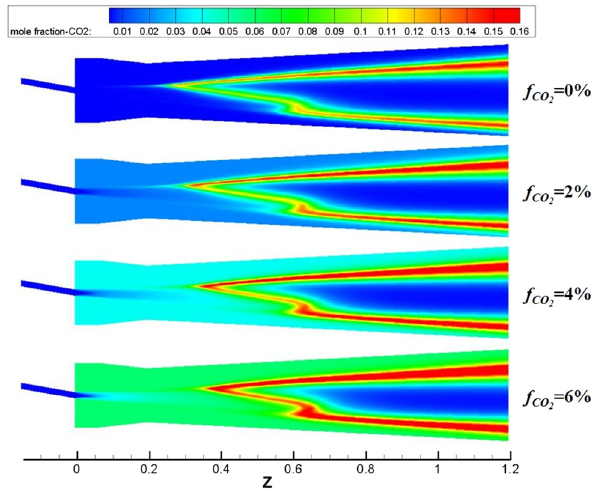
Figure 8: Distribution of YZ plane CO 2 volume fraction in a furnace with a di ff erent f rate in the hot blast. CO 2